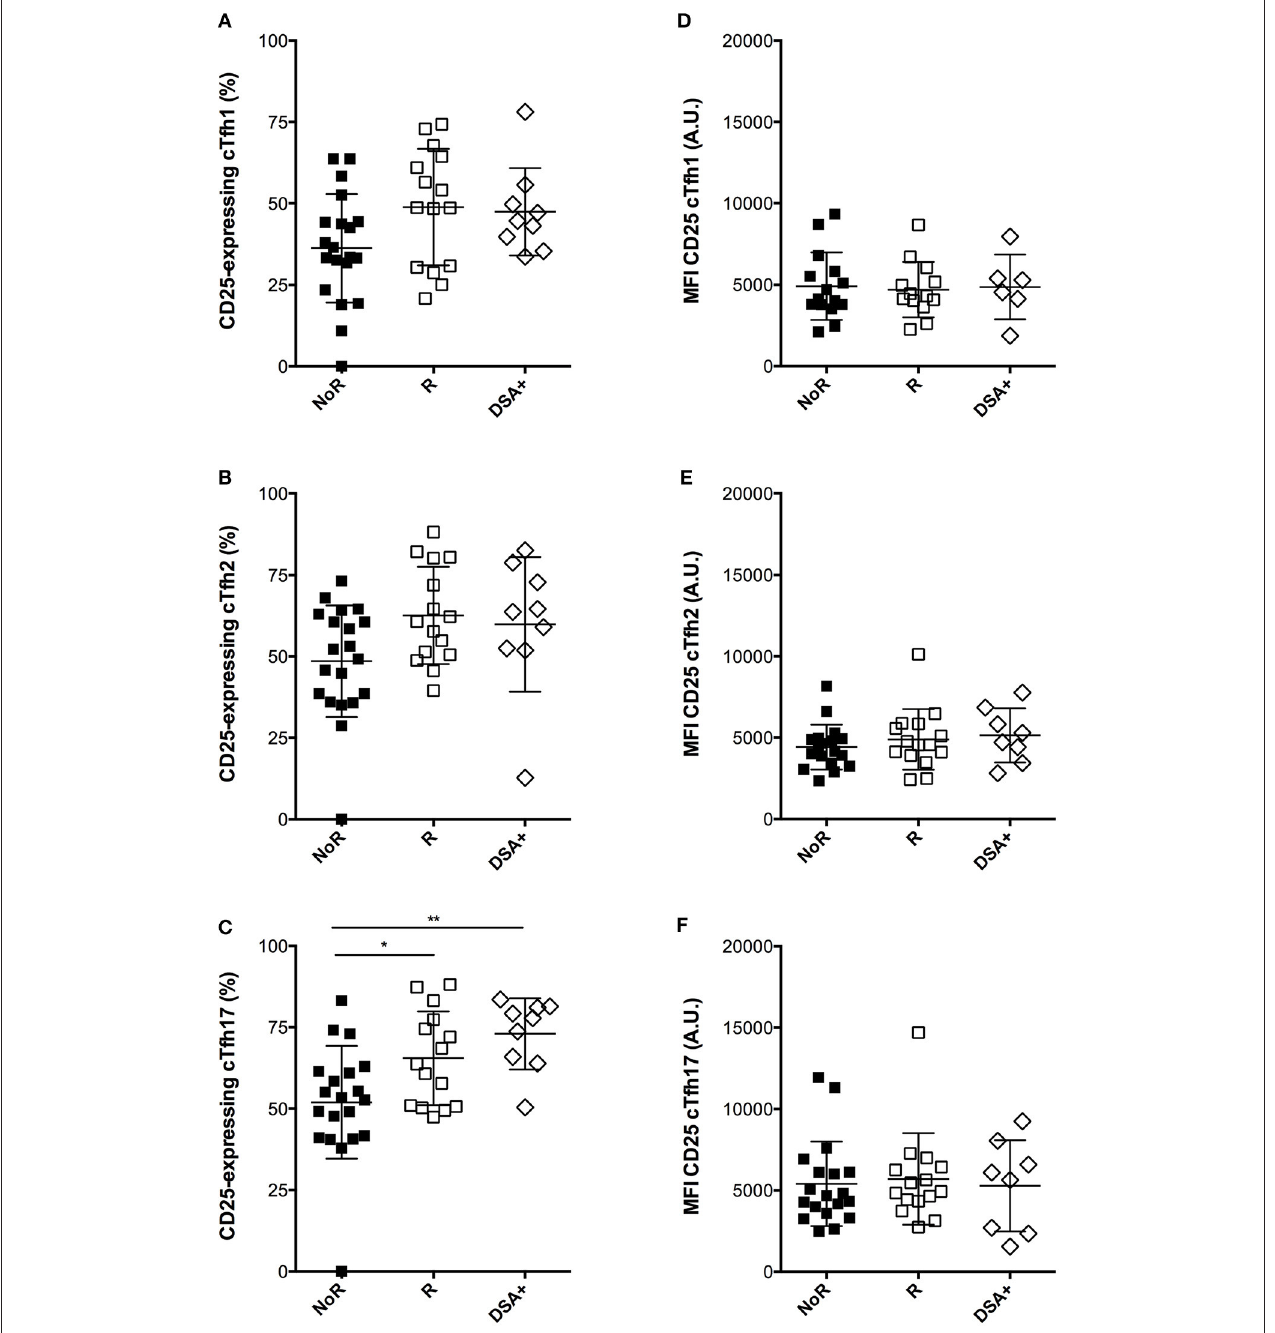
FIGURE 7 | Comparison of the dynamic profile of cTfh of responders and non-responders to A/Switzerland hemagglutinin. (A–C) PBMC of transplant patients were collected just before vaccination. The percentage of CD25-expressing cTfh of each of the three subsets ( A : cTfh1; B : Tfh2; C : cTfh17) was enumerated by flow cytometry after 24h of in vitro stimulation. Data from transplant patients that had developed (Responders, R; n = 15; open square) or not developed (non-responders, NoR; n = 20; black square) antibodies against Switzerland hemagglutinin are compared between themselves and with that of a cohort of nine transplant recipients that had just developed DSA (group DSA + ). (D–F) The level of expression of CD25 (as reflected by mean fluorescence intensity, MFI) was measured by flow cytometry after 24h of in vitro stimulation for each of the three subsets of cTfh ( D : cTfh1; E : Tfh2; F : cTfh17) and compared between the three groups. Each symbol represents a patient, mean ± SD is indicated. * p < 0.05; ** p < 0.01; ANOVA, Dunn’s multiple comparisons test.